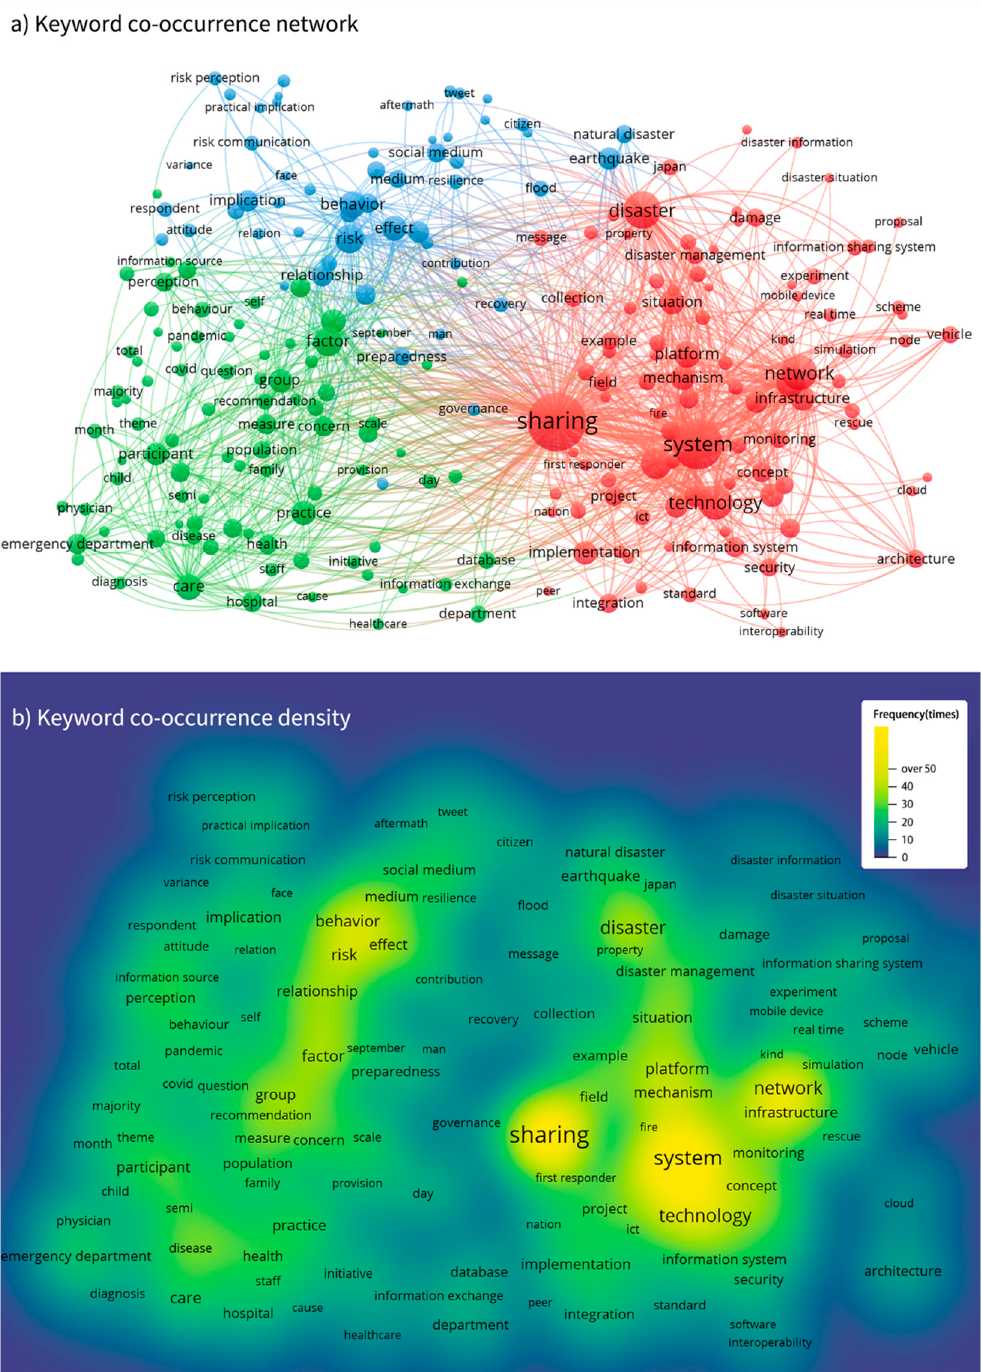
Figure 5. Keyword co-occurrence network and density map.